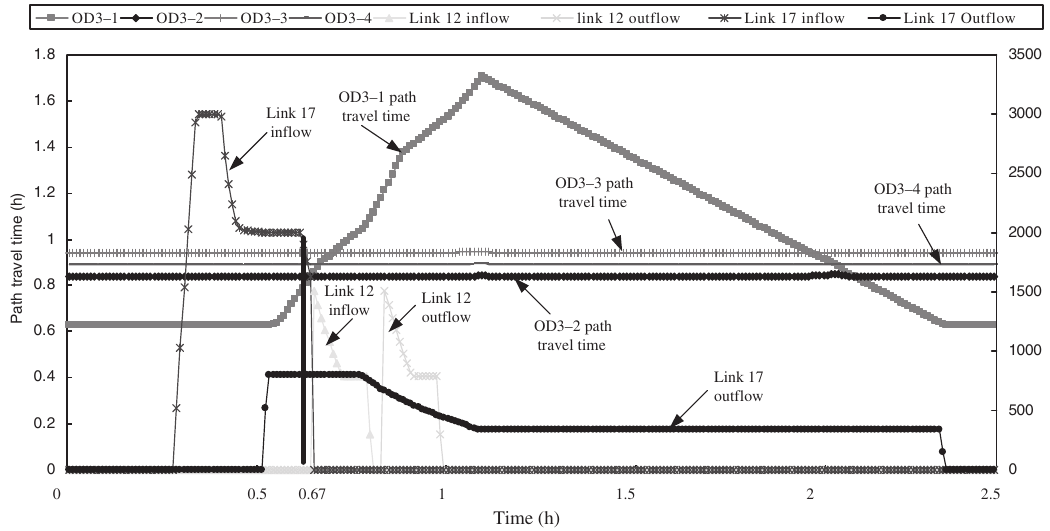
Fig. 5. Car flow and instantaneous travel time on Links 12 and 17